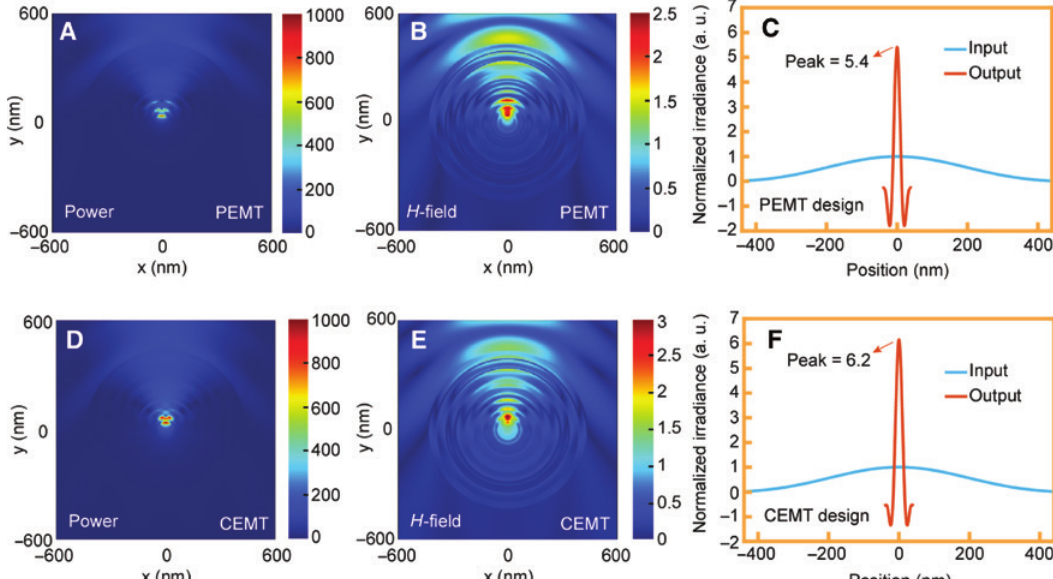
Figure 4: Full-wave field-mapping simulation of the nanofocusing device with nine pairs of binary metal-dielectric layers. (A–C) PEMT or (D–F) CEMT is used for two distinct designs. (A, D) Simulated irradiances and (B, E) H -field magnitude at λ = 365 nm generated by the exact non-paraxial Gaussian TM beam with a waist of w = λ . (C, F) Plots of the normalized irradiance for the nanofocusing device with nine pairs of binary metal-dielectric layers.